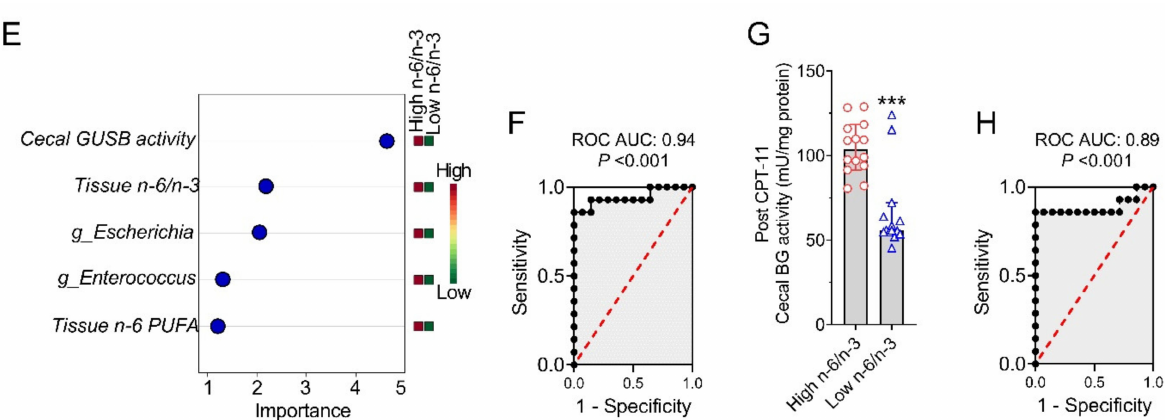
Figure 7. Decreased tissue n-6/n-3 ratio reduces CPT-11-induced imbalances in the host–gut mi- crobiome interactions . ( A , B ) Host–microbiota interaction network built from Spearman’s nonpara- metric rank correlation coefficient ( p < 0.05) between host parameters and entire microbial parameters (genus-level) of WT+CPT-11 vs. FAT-1+CPT-1 ( A ) and CO+CPT-11 vs. FO+CPT-11 ( B ) comparisons. Nodes (filled squares) in panel A represent host parameters (cyan) and microbes (olive). Nodes in panel B represent host parameters (filled squares colored black) and microbes (different shapes indicate different phylum and colored light black). Lines (edges) represent statistically significant correlations ( p < 0.05) and are colored blue for positive and red for negative correlations. Edge size reflects the magnitude of the correlation. ( C ) Multiple Factor Analysis superimposing the host and gut microbiome (genus-level) data associated with a high tissue n-6/n-3 ratio (WT+CPT-11/CO+CPT- 11 samples) and a low tissue n-6/n-3 PUFA ratio (FAT-1+CPT-11/FO+CPT-11 samples). Each line connects the host and microbial data from one sample. One end of each connecting line for an observation indicates the host (differently colored to indicate the groups), and another end (dark yellow) indicates the gut microbiota (GM). ( D ) Principal component analysis (PCA) of the host and gut microbiome (genus-level) data associated with a high n-6/n-3 ratio and a low n-6/n-3 PUFA ratio. ( E , F ) Biomarker analysis using multivariate [Random Forests (RF) classification with PLS-DA feature ranking method] receiver operator characteristic curve (ROC) based exploratory analysis performed on the combined host and microbial parameters. ( G ) Post-CPT-11 cecal contents beta-glucuronidase (GUSB) activity measurements were associated with a high n-6/n-3 ratio and a low n-6/n-3 PUFA ratio. ( H ) ROC curve generated with classical univariate ROC curve analysis showing the sensitivity and specificity for cecal contents GUSB activity. Data are shown as mean ± standard error of the mean. *** p < 0.001, nonparametric Mann–Whitney